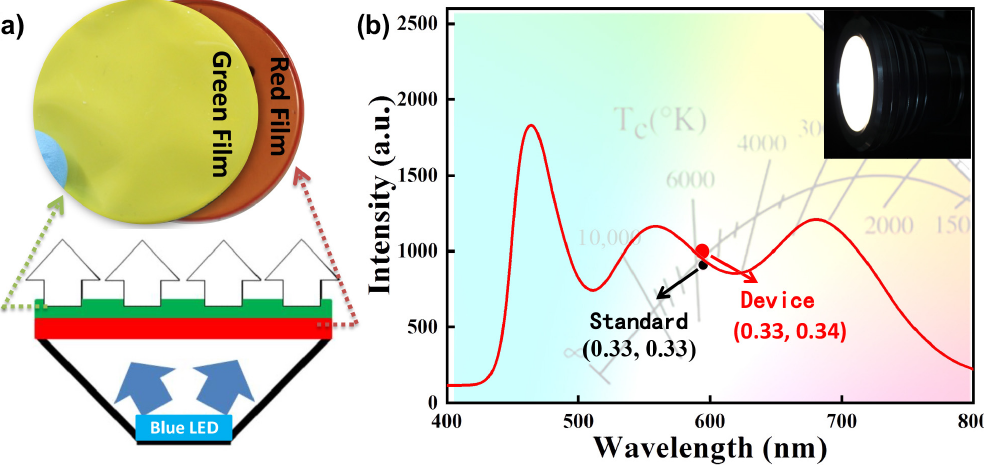
Figure 7. ( a ) Schematic diagram of the white light LED with remote structure by combinating the blue LED chip and the dual-layer CuInS 2 /PMMA composite film; ( b ) the white light spectrum and the corresponding color coordinate of remote white LED in the inset.